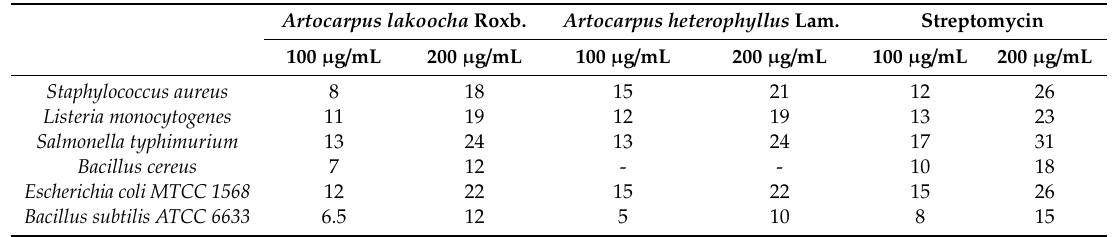
Table 2. Inhibition zones (mm) for common foodborne pathogens determined at 37 ◦ C after 24 h of